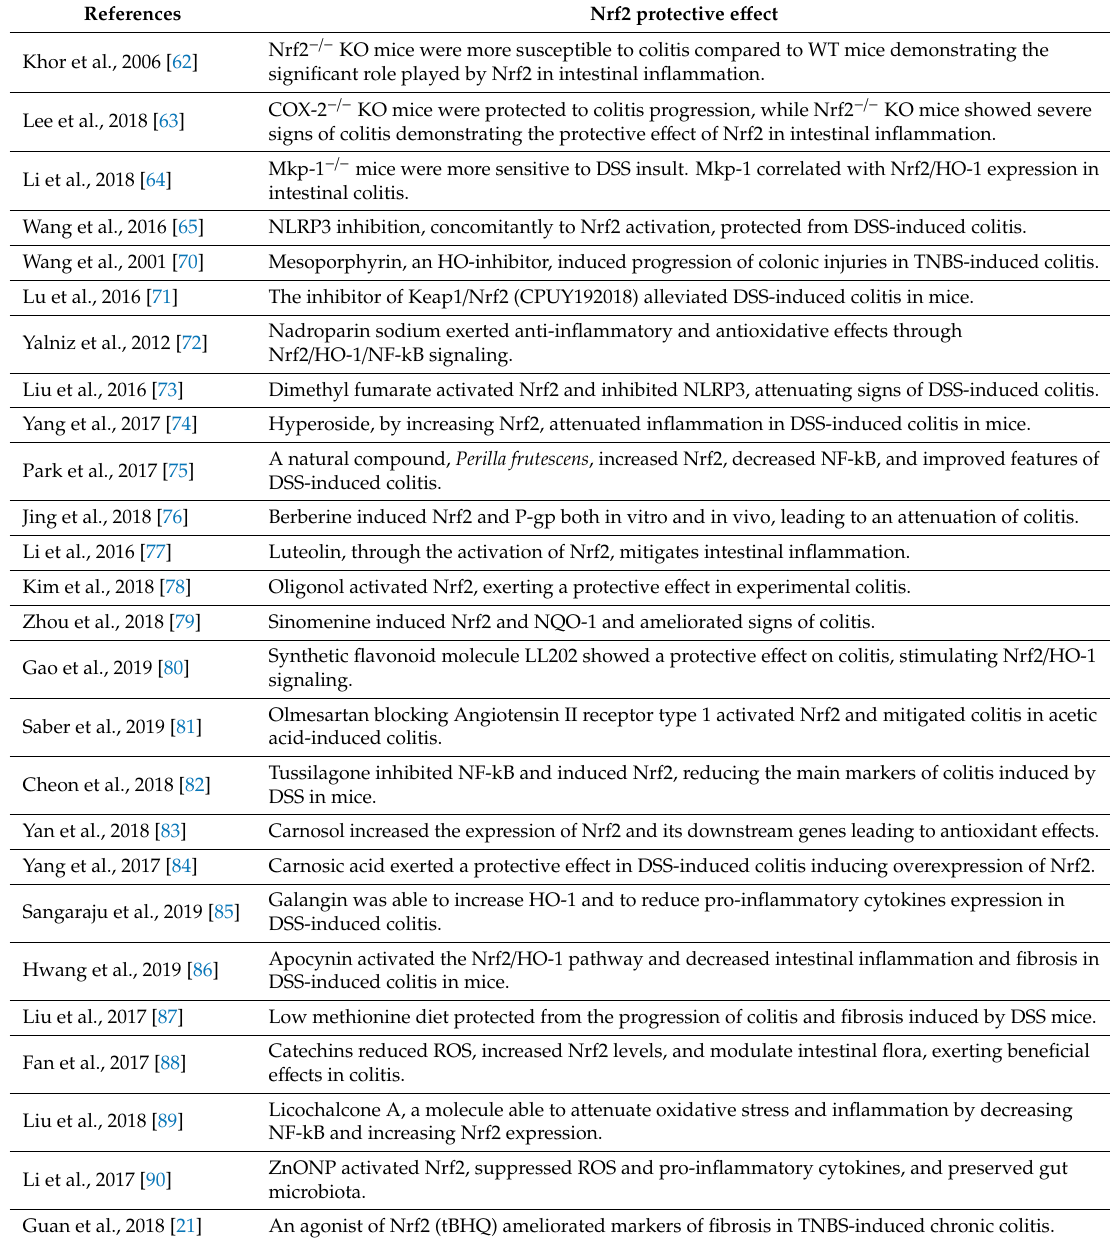
Table 2. Studies assessing Nrf2 involvement in intestinal inflammation and